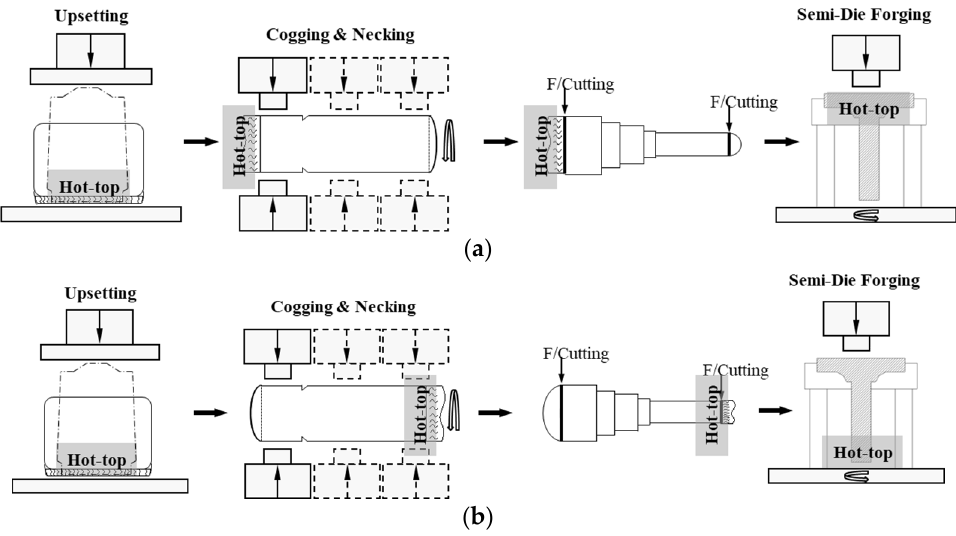
Figure 7. Schematic drawing of the main shaft forging: ( a ) Method 1; ( b ) Method 2.